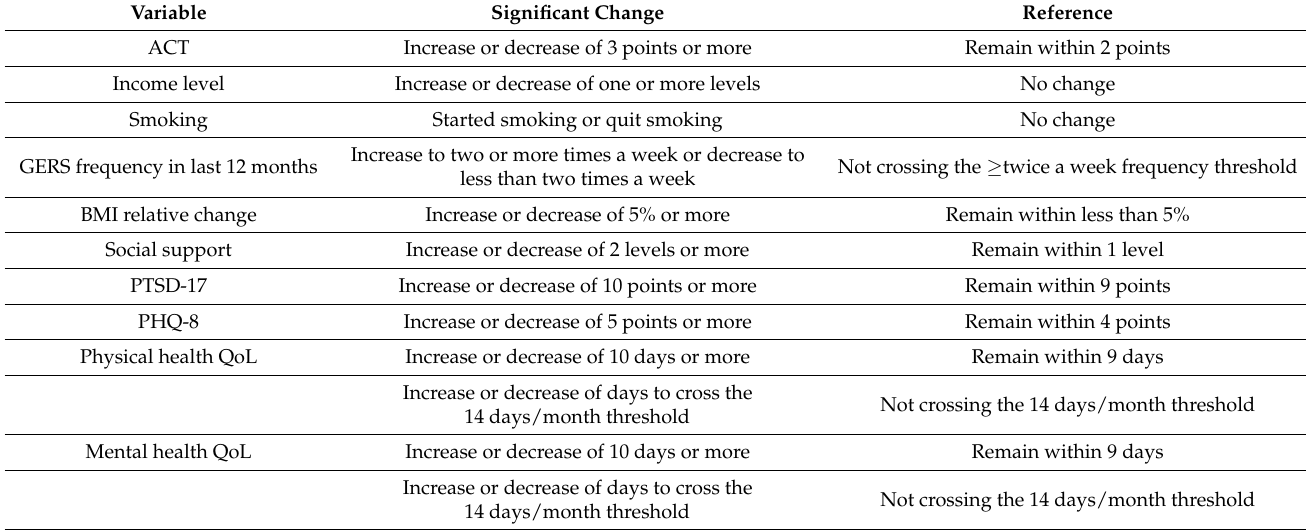
Table 1. Change from Wave 3 to Wave